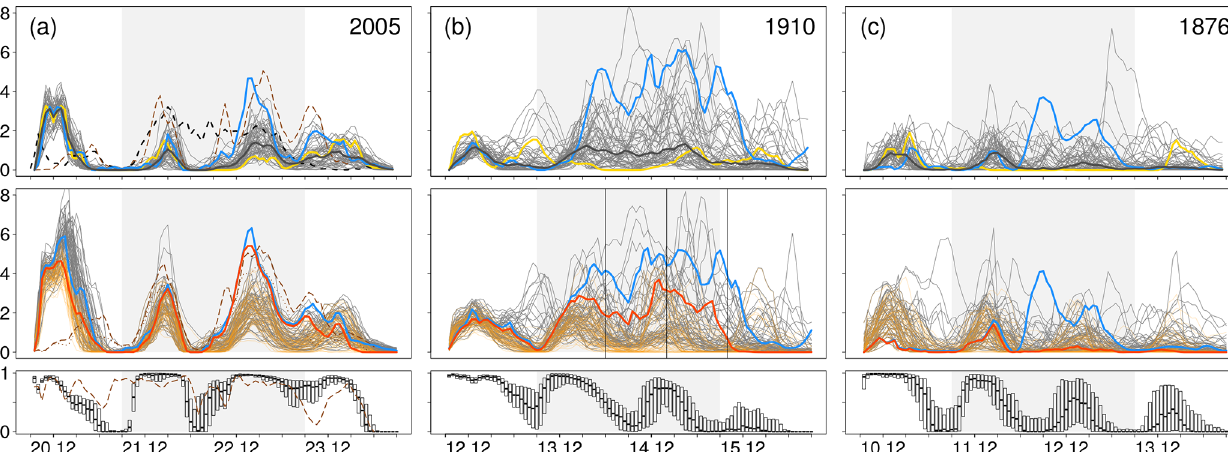
Figure 4. Time series of simulated precipitation over northern Switzerland for (a) 20 August 2005 06:00UTC to 24 August 2005 06:00UTC, (b) 12 June 1910 06:00UTC to 16 June 1910 06:00UTC, and (c) 10 June 1876 06:00UTC to 14 June 1876 06:00UTC. Dark gray lines indicate mean hourly precipitation (mmh − 1 ) within the control area over northern Switzerland for the 56 downscaled ensemble members, as simulated for the 3km domain (upper panels) and the 9km domain (middle panels). In the upper panels, the thick black (yellow, blue) solid lines mark the median (minimum-precipitation, high-precipitation) members, as selected for Figs. 5 to 8 and Fig. 10. In the middle panels, thin orange lines show the contribution of the convection parametrization to the total precipitation in the 9km domain. The thick dark orange lines indicate convective precipitation for the selected high-precipitation members. The bottom panels show the proportion of convective precipitation with respect to total precipitation in the 9km domain. In panel (a) , the dashed black line shows the corresponding hourly precipitation calculated from CombiPrecip, and the dashed brown lines show the precipitation from the ERAI-WRF experiment with 4 domains; the convective contribution is shown with points in the middle panel. Black vertical lines in (b) indicate the instances in time selected for Fig. 10. Gray shadings mark the most intense 48h periods of precipitation according to Fig. A1.